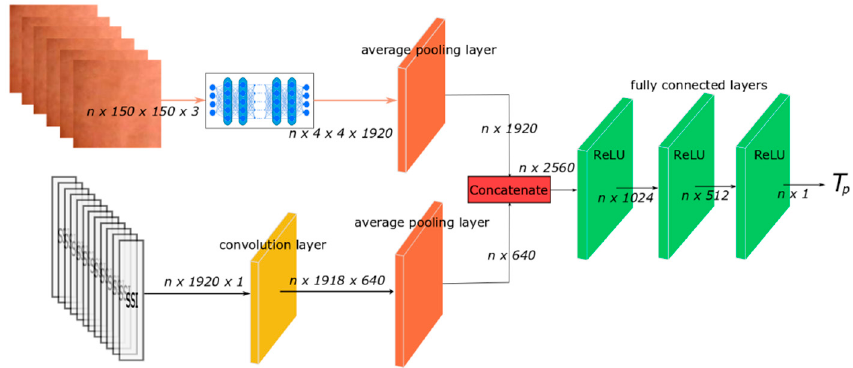
Figure 2. NISDL method II. (SSI values and skin images were processed by deep learning networks. Two kinds of features were extracted and the features were combined.).